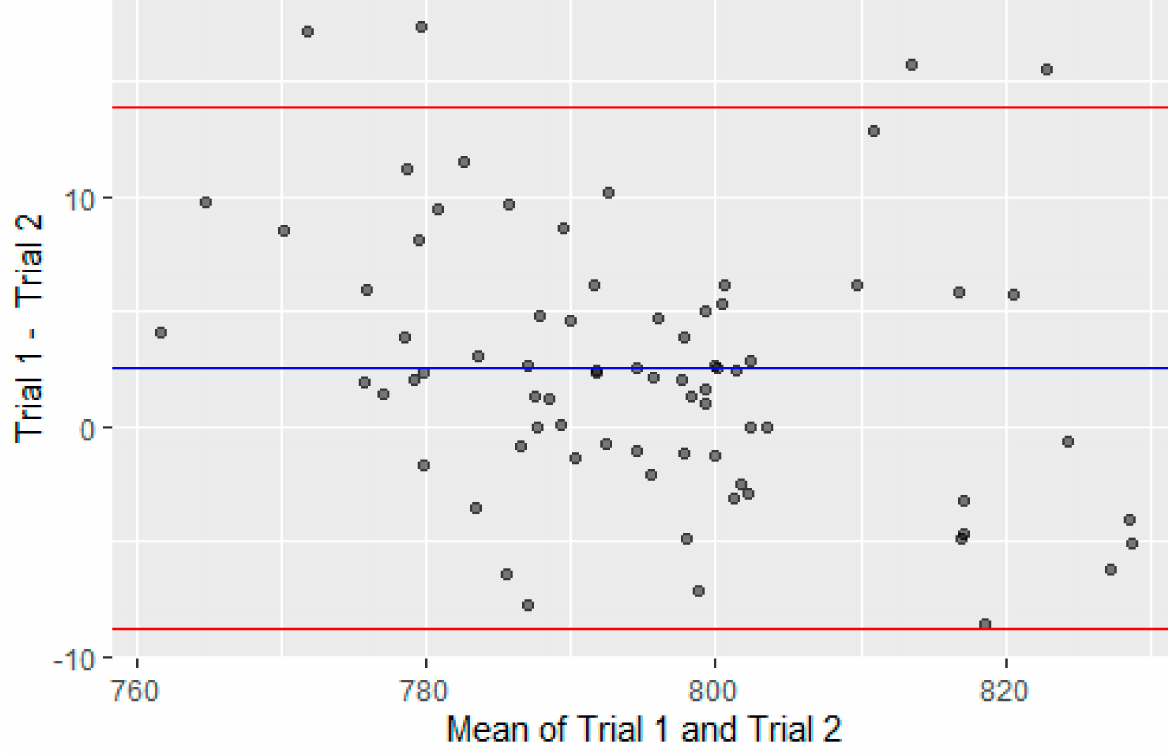
Figure 2. Bland–Altman analysis for between trial differences for eccentric back squat force-velocity assessment in trained athletes. Data shown is for log-transformed eccentric peak force across all loads